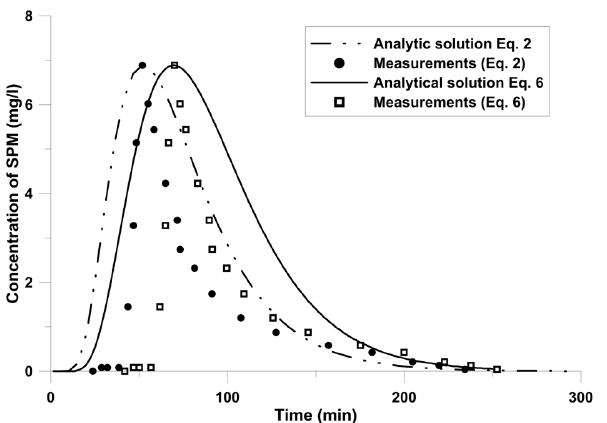
Figure 10. Calculated and measured variation in SPM concentration with time for the first Fig. 10. Calculated and measured variation in SPM concentration event in the Agnesberg landslide using two different analytical solutions (Eqs. 2 and 6). with time for the first event in the Agnesberg landslide, using two different analytical solutions (Eqs. 2 and 6).